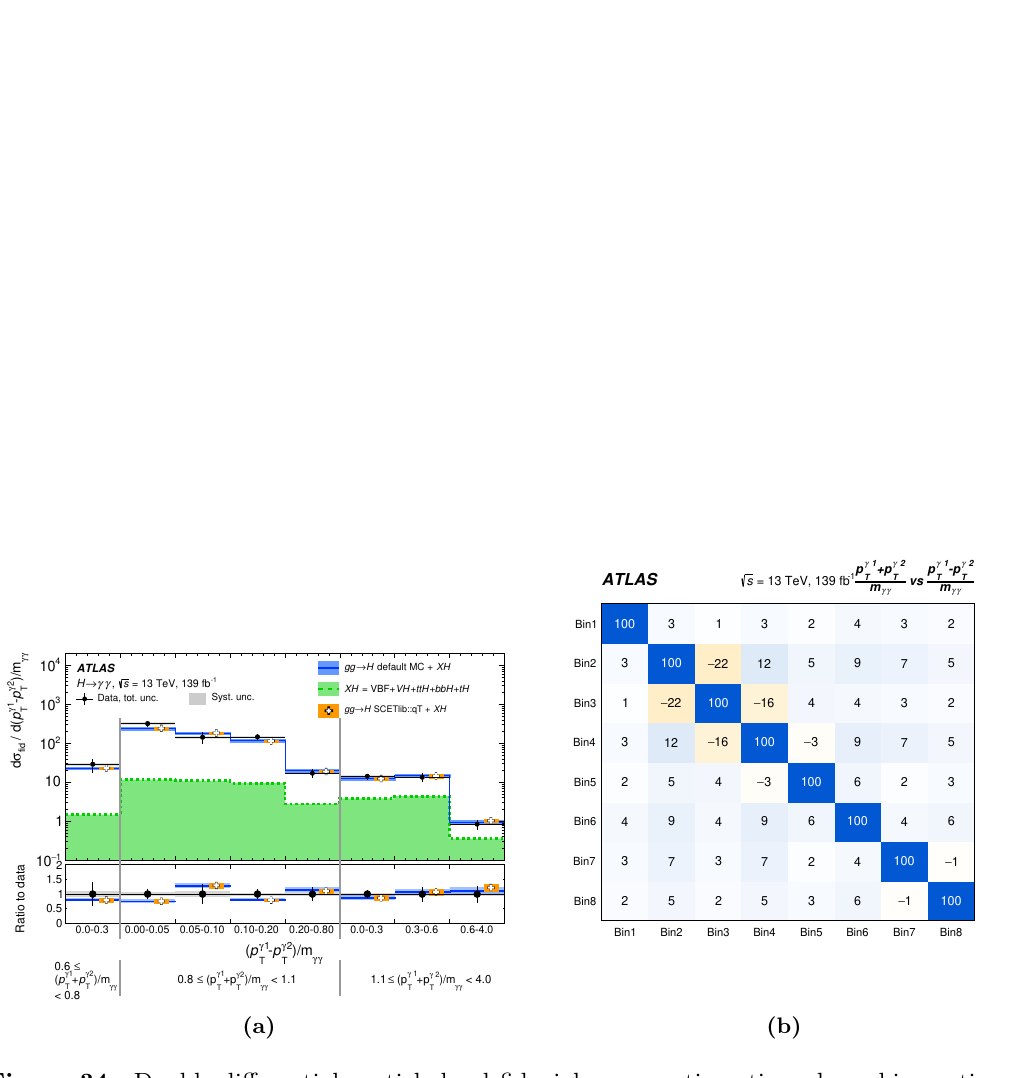
Figure 34. Double-differential particle-level fiducial cross-sections times branching ratio of (a) ( p γ 1 ) /m in bins of ( p γ 1 + p γ 2 ) /m together with the corresponding correlation matrix (b). − p γ 2 γγ γγ T T T T The order of the bins in the correlation plots is the same as in the plots with the values of the